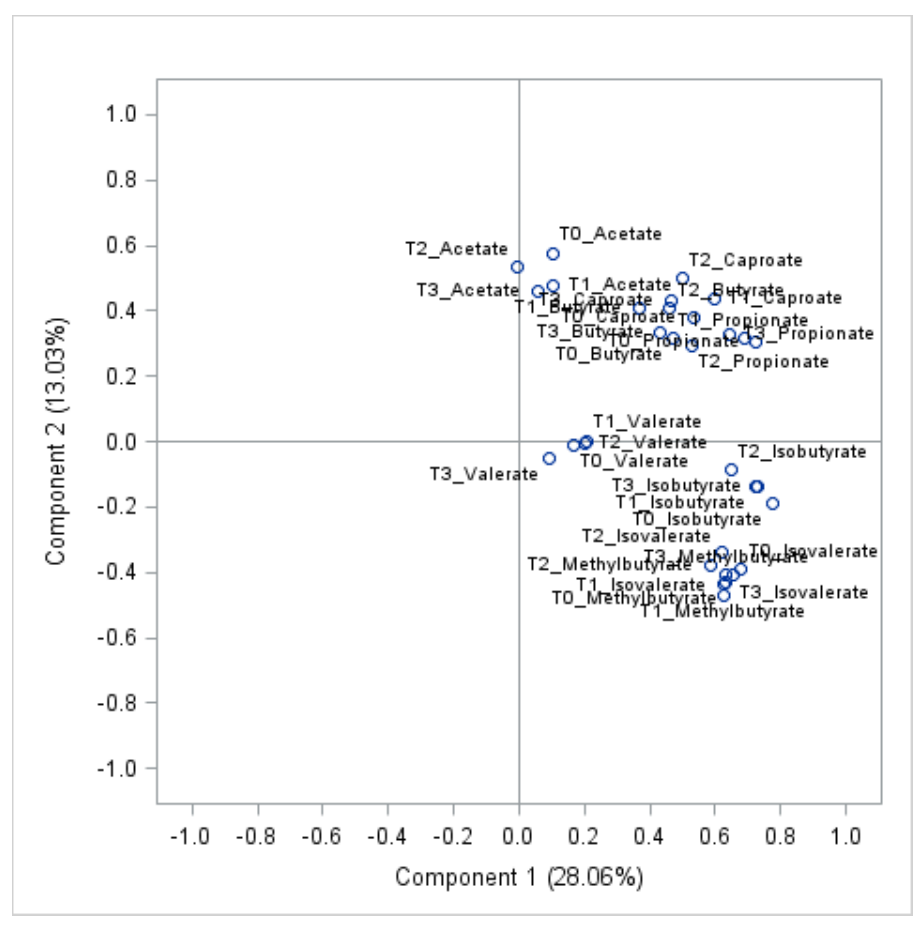
Figure 4. PCA plot of the first two principal components generated from all eight (8) SCFAs at four (4) different time points at baseline (T0), week 12 (T1), 24 (T2) and 50 (T3), n = 126.